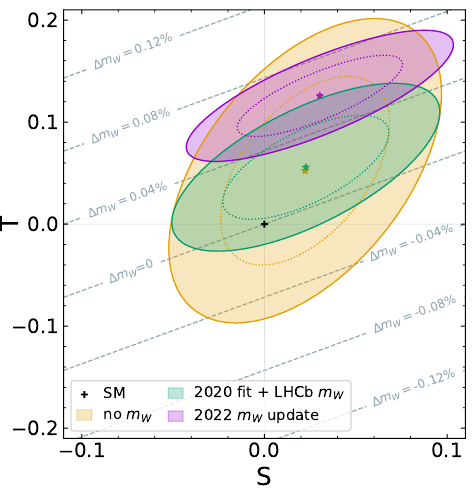
Figure 2 . The 68% and 95% CL contours of fits to the oblique parameters S and T , which are equivalent to a fit including the SMEFT operators O HWB and O HD , see eq. (2.5). The orange, green, and purple contours are the result of fits omitting m W measurements, with m W previous to the recent CDF measurement, and including the latest CDF result. We see a clear pull away from the SM value at the origin due to the CDF result, which nevertheless remains compatible with the range allowed by other data. The percentage shifts in the W mass are denoted by dashed grey